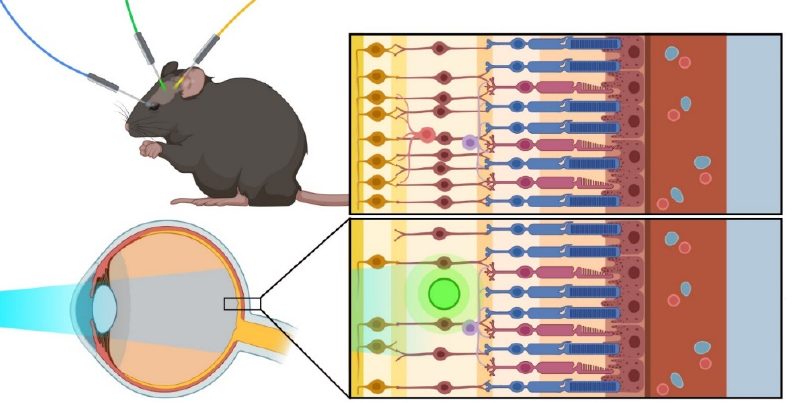
Figure 1. Optogenetic approaches: The favorite models for optogenetic therapy include mouse models, which can be adapted to study and treat different eye-related conditions using various optogenetic